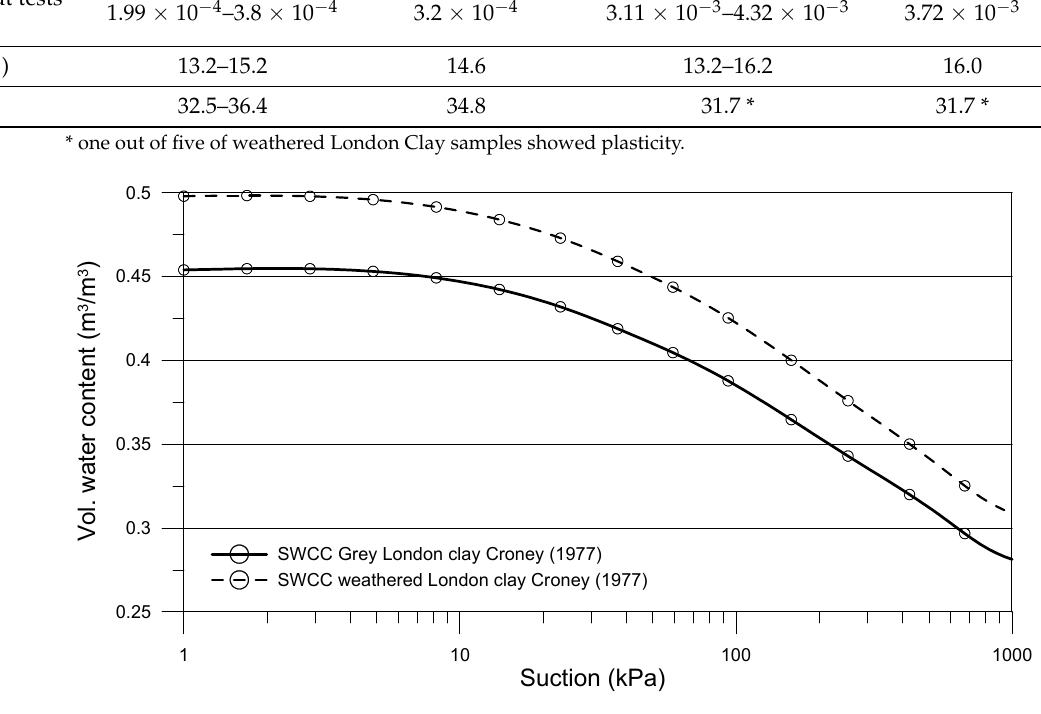
Figure 3. Transformed SWCCs for the Newbury cutting soil.